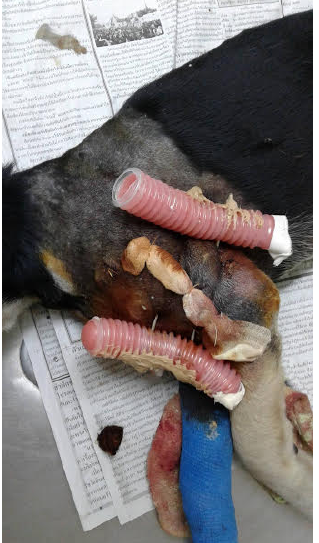
Fig. 13. Acrylic bar in humeral external skeletal fixation